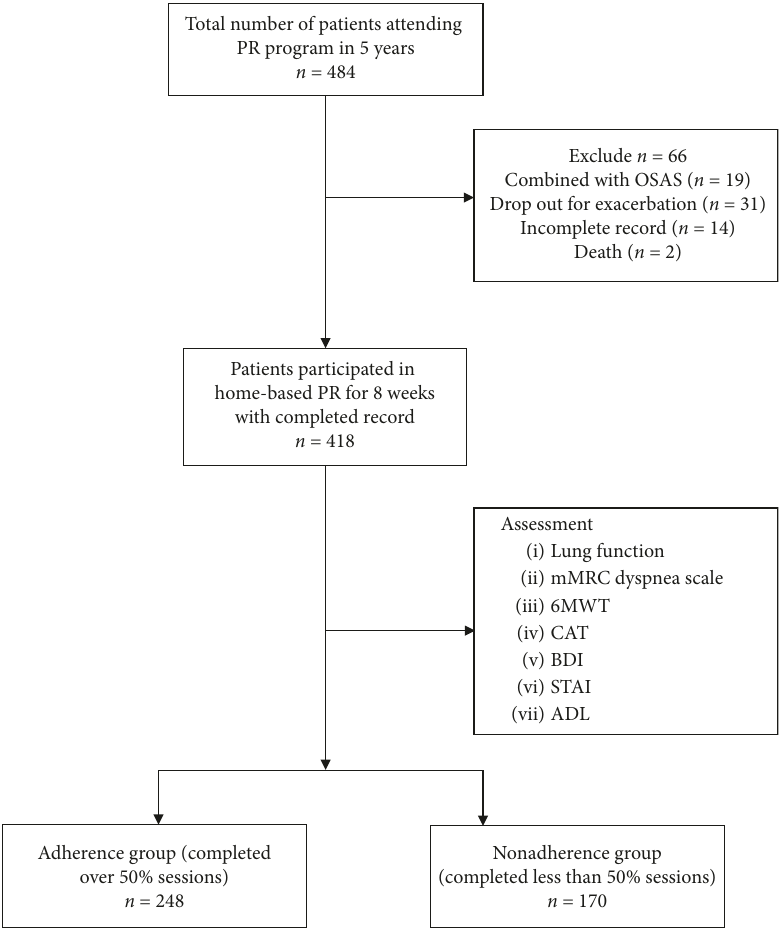
Figure 1: Flowchart of the study population. Note: PR: pulmonary rehabilitation; mMRC: modified Medical Research Council. 6MWT: 6- minute walking test; CAT: COPD assessment test; BDI: Beck Depression Inventory; STAI: State-Trait Anxiety Inventory; ADL: activities of daily living. Table 2: Clinical characteristics of participants at baseline ( n �